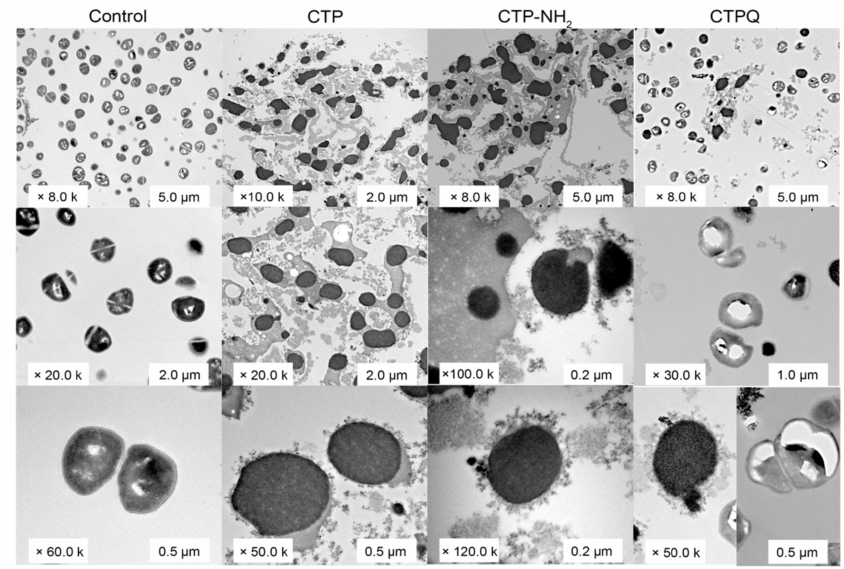
Figure 8. TEM assay of S. aureus ATCC 43300 treated with CTPs (CTP, CTP-NH2, and CTPQ) at the MIC (32 µ